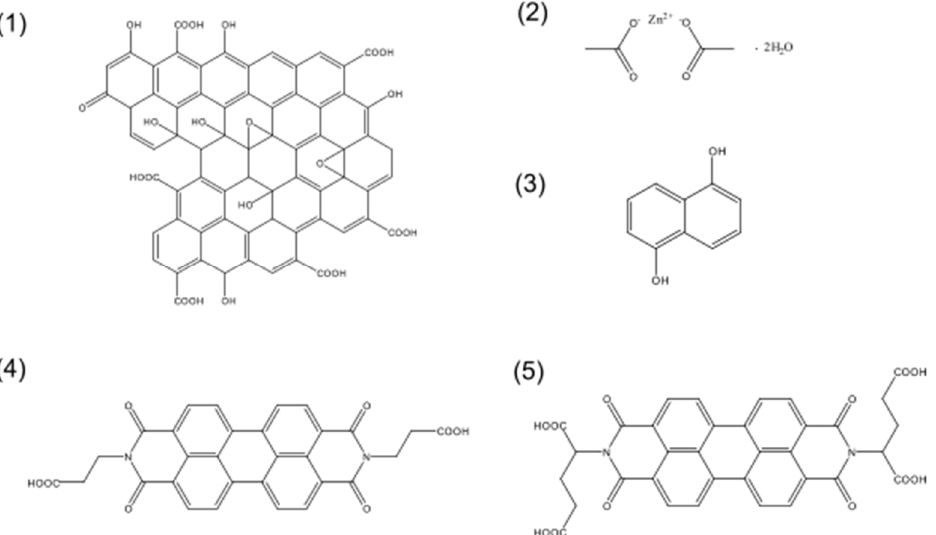
Figure 1. Structures of components of the GO/Zn (OAc) 2 /PDI hybrids: ( 1 ) graphene oxide, ( 2 ) zinc acetate dihydrate, ( 3 ) 1,5-dihydroxynaphthalene, ( 4 ) PA-PDI, ( 5 ) glu-PDI.